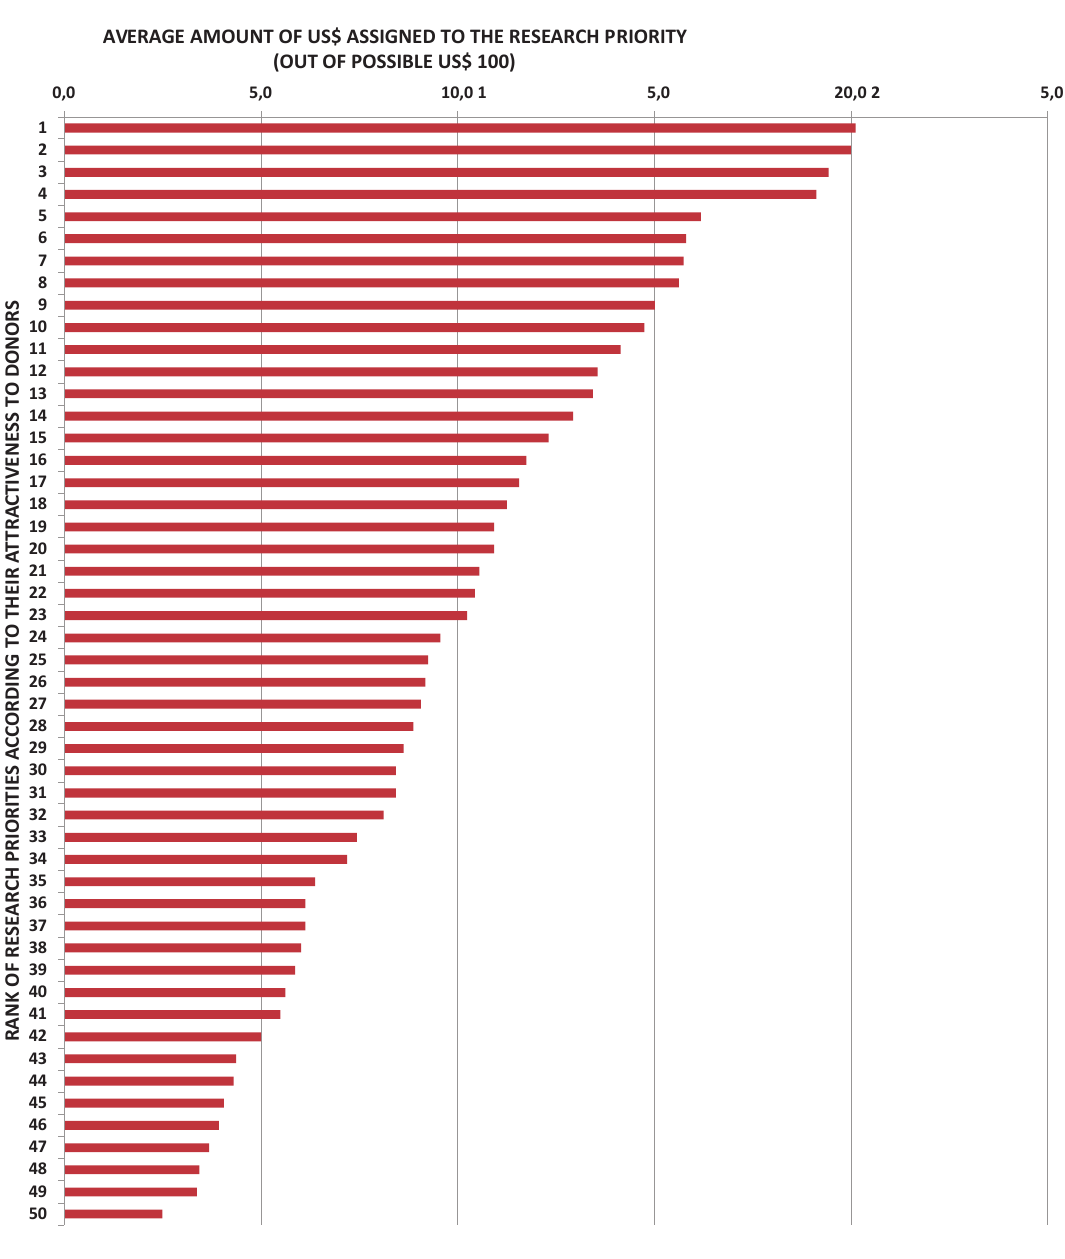
Figure 2. The results of the collective input from 16 funder representatives, showing large differences in funding attractiveness between 50 research priorities. No substantial differences in funding attractiveness would be indicated by equality of the scores on the horizontal axis at the US$ 10.0